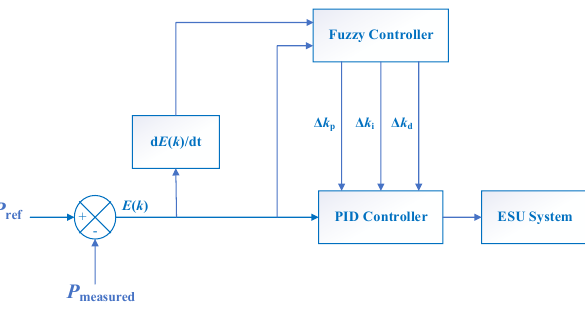
Fig.6: FLC-PID controller for the proposed